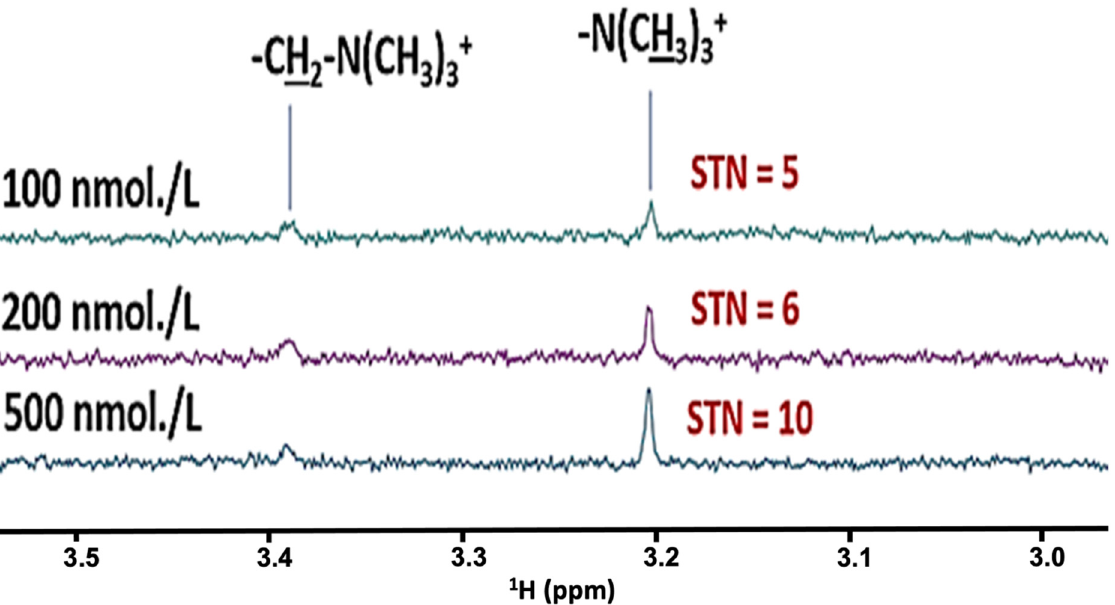
Figure 3. Sensitivity of 1 H NMR Analysis for Salivary Metabolomics Experiments. Partial (3.06–3.56 ppm regions of) 600 MHz 1 H NMR spectra acquired on phosphate-buffered (10.00 mmol./L, pH 7.00) aqueous solutions of choline chloride (only 100, 200 and 500 nmol./L). Spectra were acquired